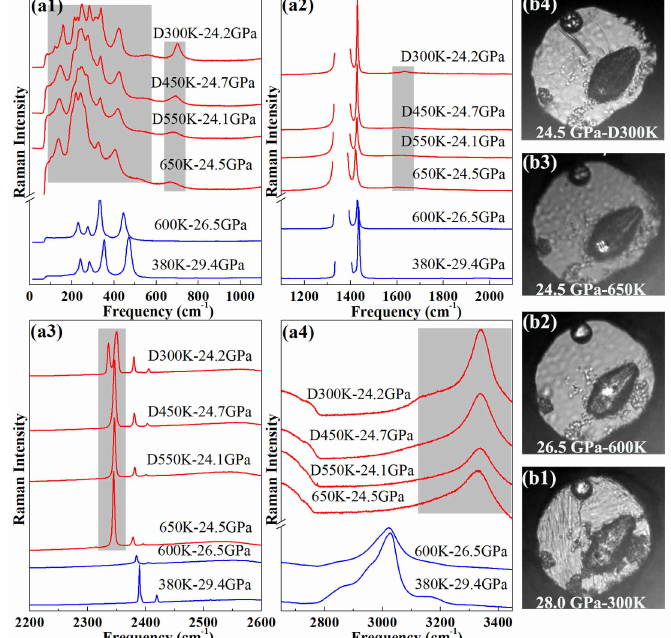
Figure 1. ( a ) Raman spectrum of AA + N 2 up to 25 GPa at different temperatures. The gray colored bands emphasize the frequency windows where major changes are observed in the sample Raman spectrum. “D” indicates that the measurement was performed on decreasing temperature ( b ) Photographs of the sample chamber at different pressures and